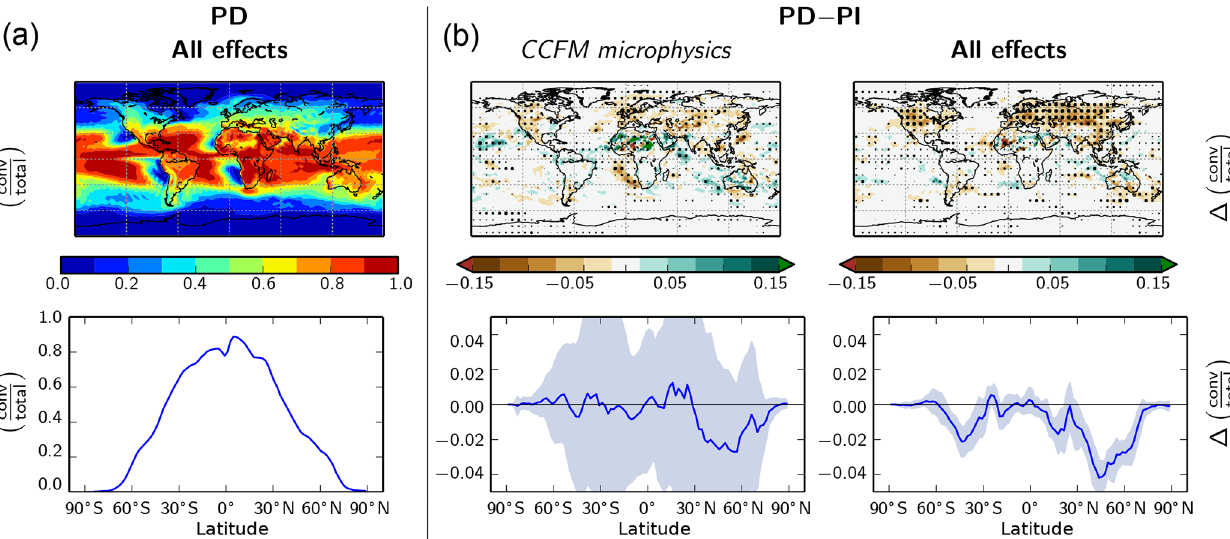
Figure 3. The 10-year mean PD (a) and PD–PI change in (top panels in b ) fraction of precipitation which comes from CCFM (rather than resolved large-scale/stratiform cloud). The right-hand plot in (b) shows the total response, while the left plot in (b) shows the component due to CCFM microphysics alone. The plots on the bottom row show the zonal mean of the maps above. (PD: present-day aerosol; PI: pre- industrial aerosol; stippling indicates areas where the PD–PI difference is statistically significant at the 95% level, while the corresponding confidence interval is shaded on the zonal mean